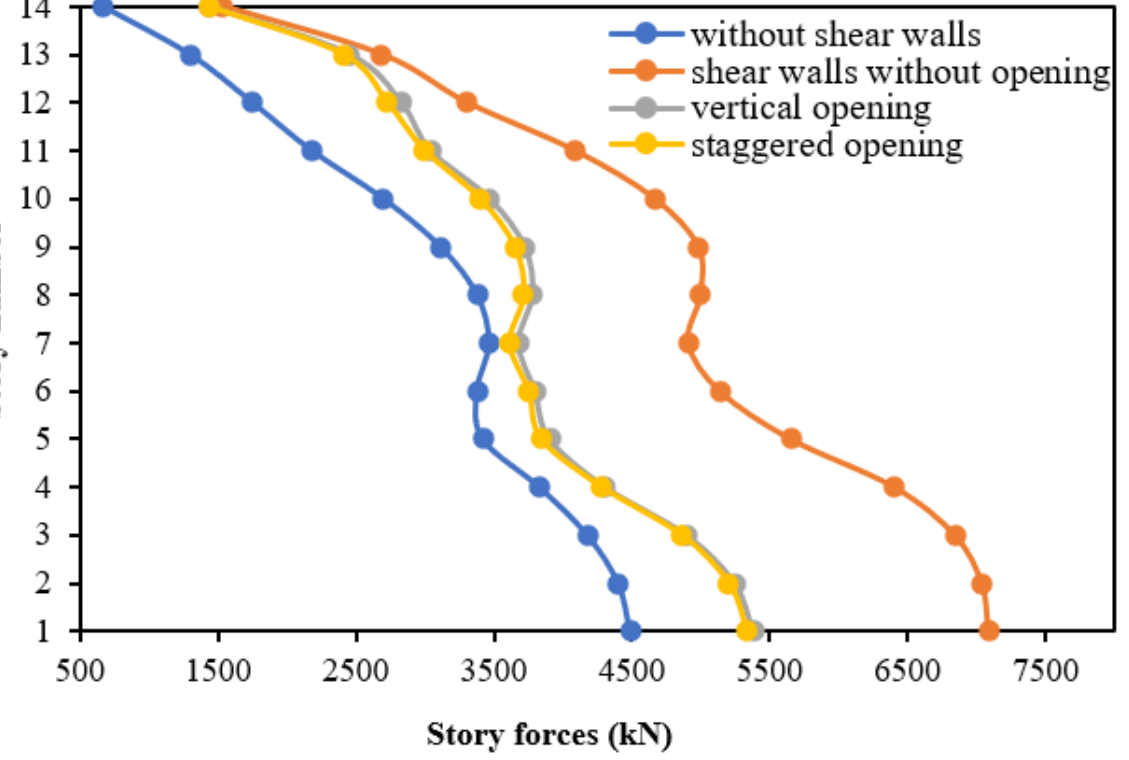
Figure 21. Story forces of the models, time history analysis, X-direction.